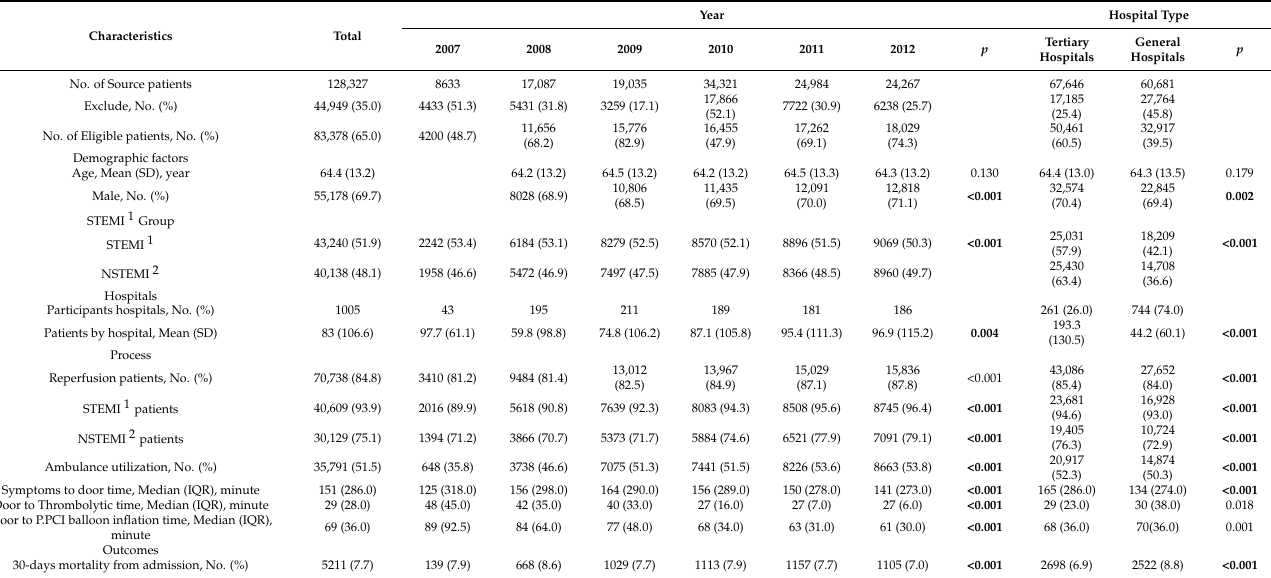
Table 1. Characteristics of